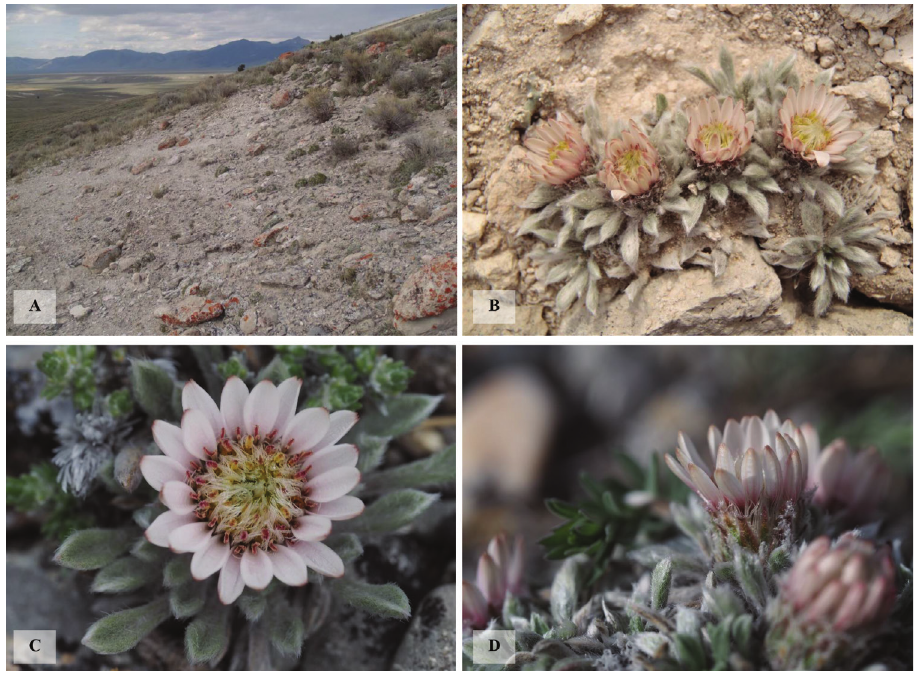
Figure 1. A habitat of the type locality of Townsendia lemhiensis B habit of Townsendia lemhiensis at the type locality C close-up of Townsendia lemhiensis capitulum D close-up of Townsendia lemhiensis phyllar- ies. Photos A-B by Björk; Photos C-D by